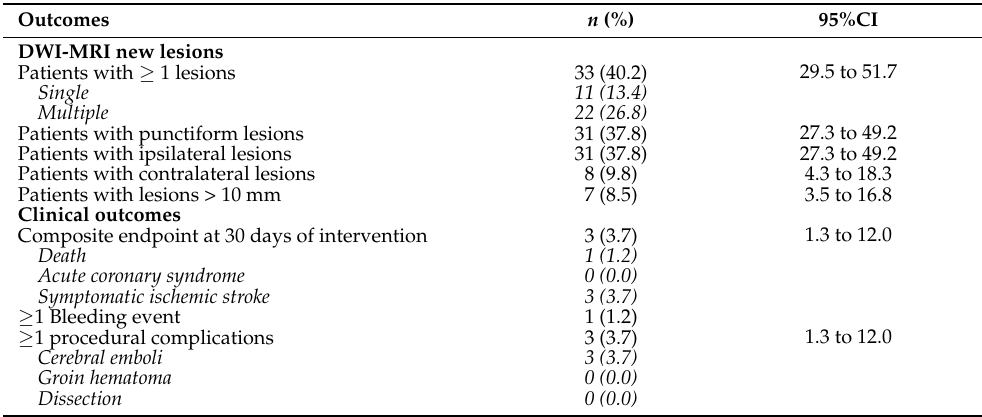
Table 2. DWI-MRI new lesions and clinical outcomes in 82 patients with symptomatic carotid stenosis >50% or symptomatic web treated by CAS using SFB.